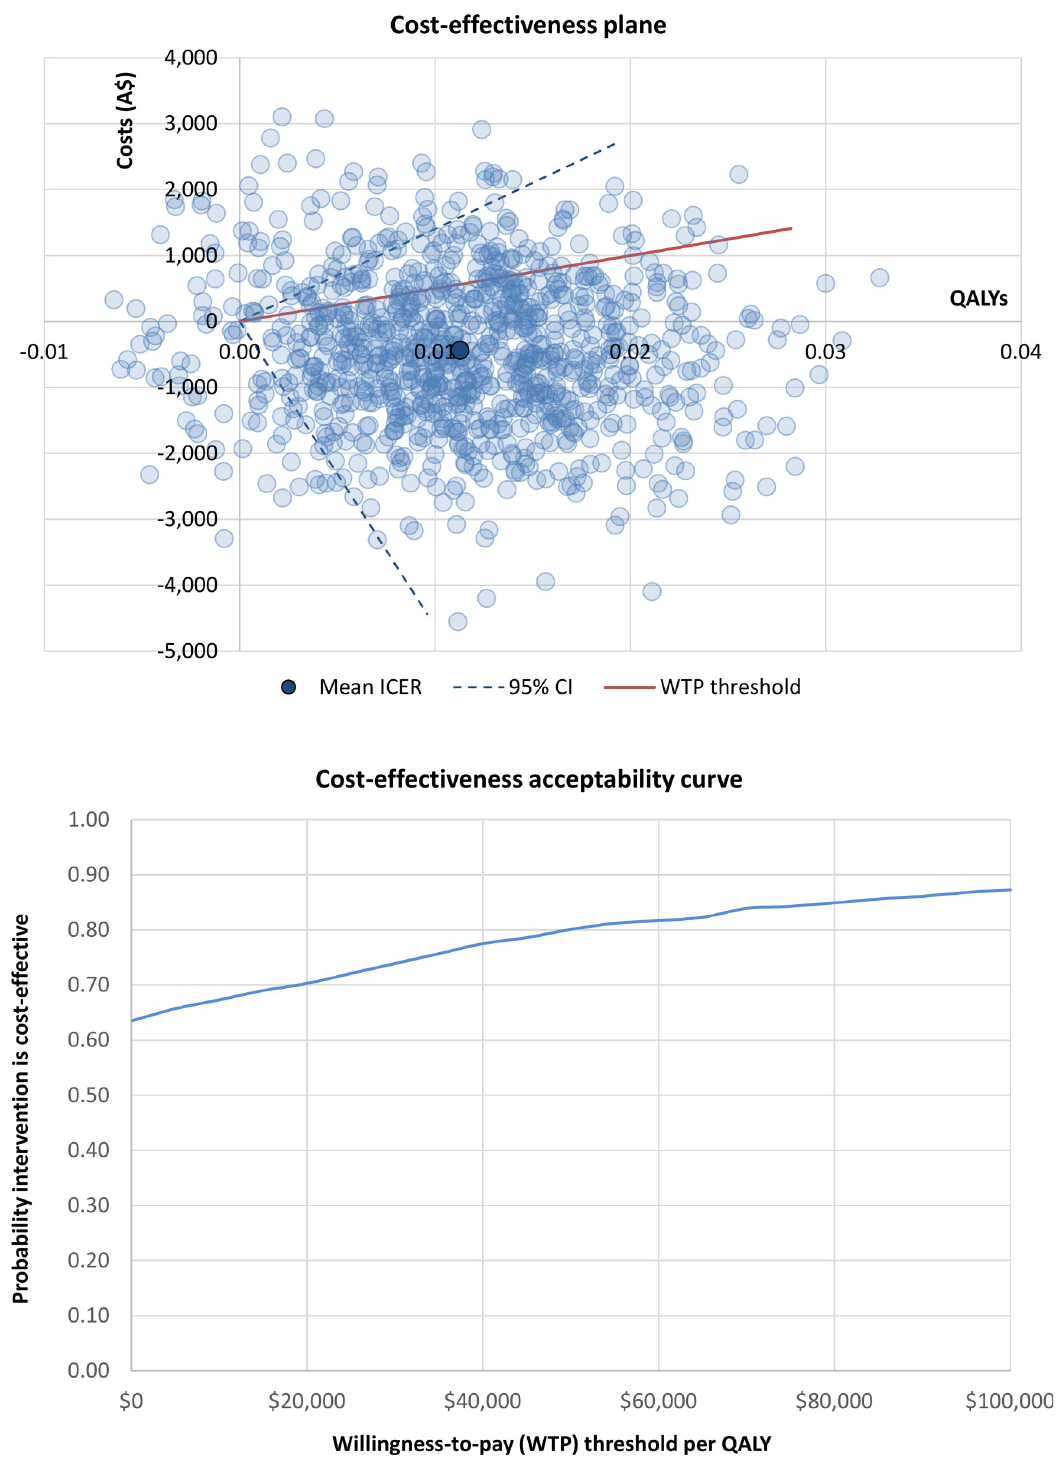
Fig 2. Cost-effectiveness results for the societal perspective across all participants at 12 months. Abbreviations: A$ = Australian dollars; CI = confidence interval; ICER = incremental cost-effectiveness ratio; QALYs = quality-adjusted life years; WTP = willingness to